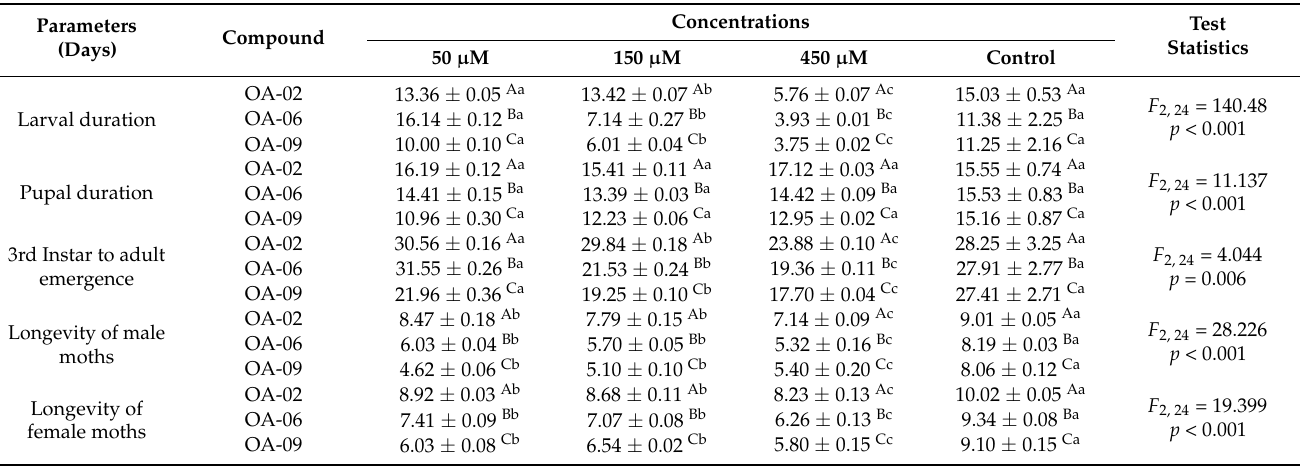
Table 4. Effect of different concentrations of OA-02, OA-06 and OA-09 compounds on developmental periods during different life stages of Helicoverpa armigera.